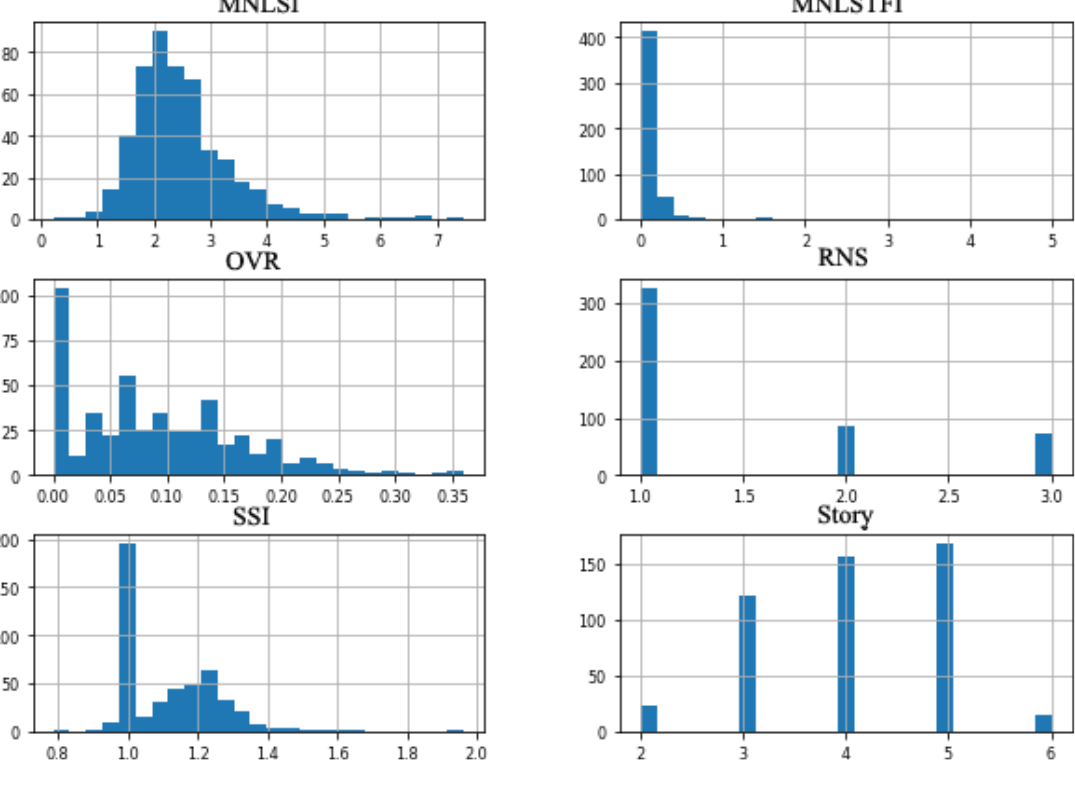
Figure 3. Distribution of data on each input